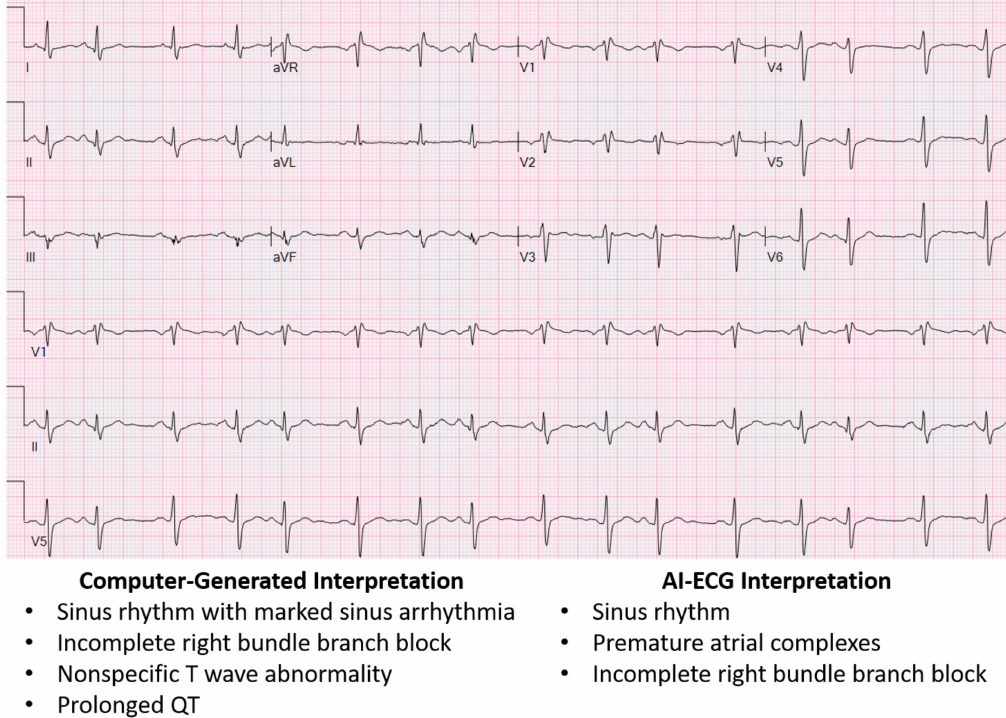
Figure 1. ECG showing traditional computer-generated interpretation versus AI-ECG interpretation. The AI-ECG interpre- tation provides a more accurate interpretation of the ECG, while the traditional computer-generated interpretation mislabels sinus arrhythmia for premature atrial complexes and overestimates the QT